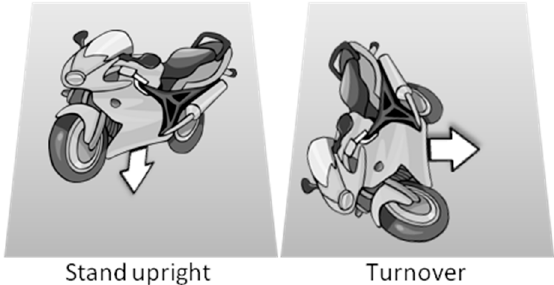
Figure 2. Direction of gas discharge from a thermally activated pressure relief device.